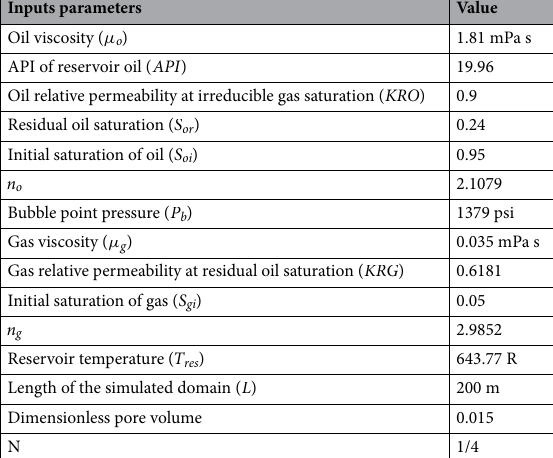
Table 4. Parameters for simulation of IFT and gas